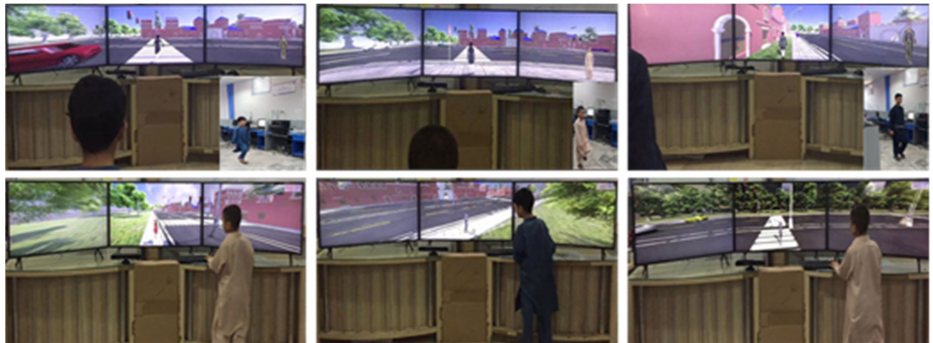
Figure 11. Students performing training